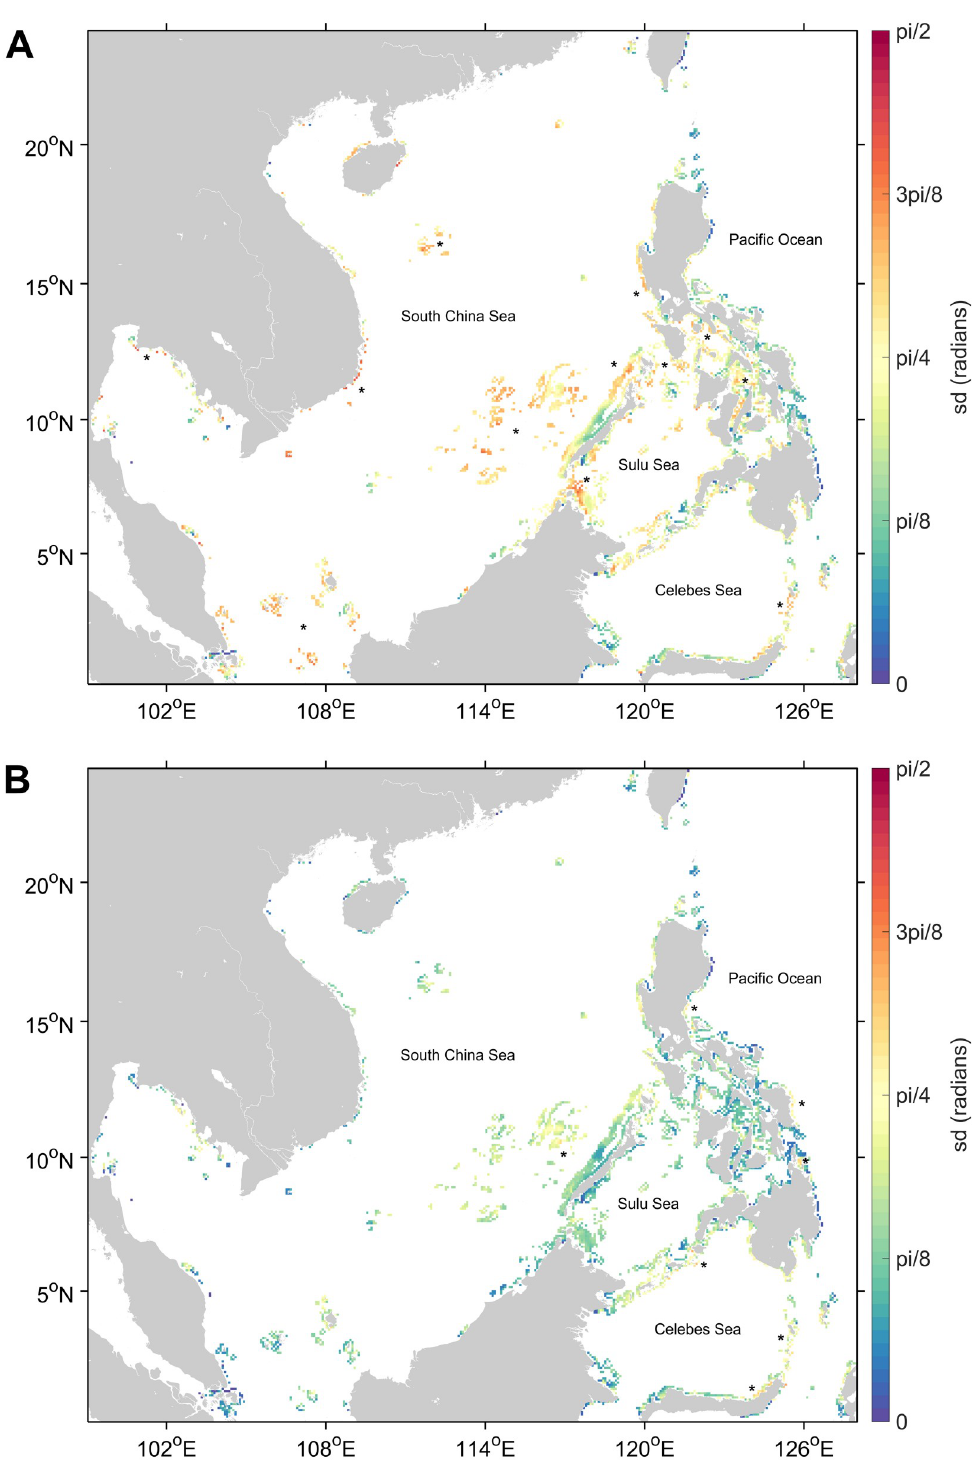
Fig 4. Variability of mean direction of exports at each reef cell. (A) shows the average standard deviation between seasons, (B) shows the average standard deviation between years. Areas marked with � indicate reefs of high variability mentioned in the